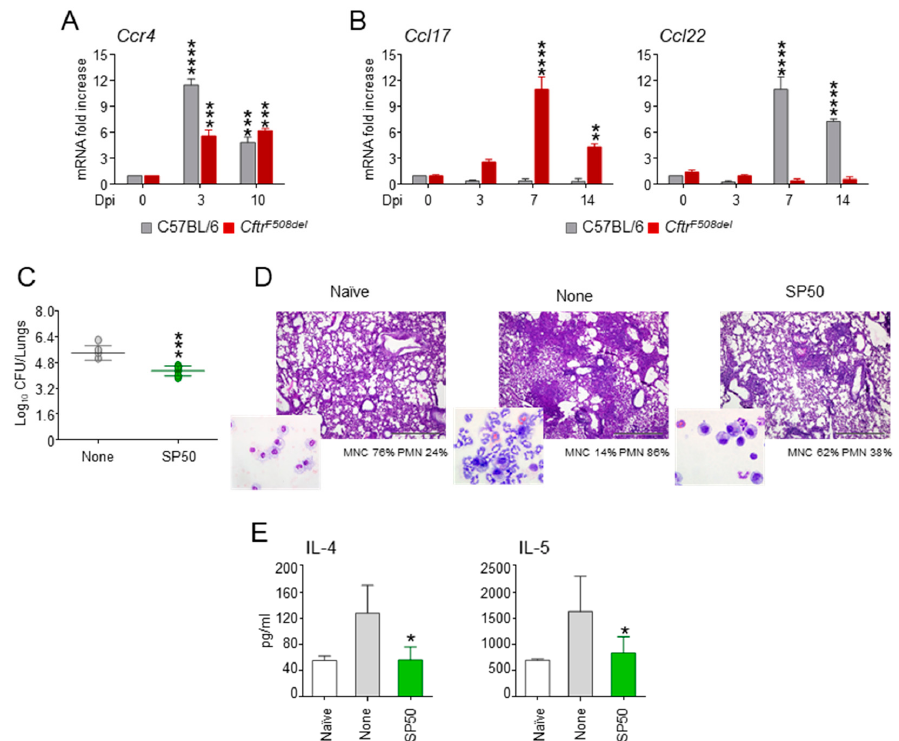
Figure 4. SP50 protects from aspergillosis in a murine model of cystic fibrosis. C57BL/6 and Cftr F508del mice were infected intranasally (in) with A. fumigatus and treated with SP50 administered (5 µ g/mouse/in) in concomitance with Aspergillus inoculation. ( A ) Expression of CCR4 and ( B ) its ligands CCL17 and CCL22 during infection. ( C ) Cftr F508de l mice were assessed for fungal growth (Log10 CFU) in the lungs at 7 days post-infection (Dpi). In ( D ) lung histology (periodic acid-Schiff staining) of A. fumigatus -infected and SP50-treated mice (% of neutrophils in the bronchoalveolar lavage are shown in the insets). ( E ) Cytokines were determined in lung homogenates 7 days after the infection by ELISA. Data are pooled from three independent experiments. Na ̈ ı ve, uninfected and untreated mice. *, p < 0.05, **, p < 0.01, ***, p < 0.001, ****, p < 0.0001, SP50 ‐ treated treated vs untreated (None) mice and Dpi 3 and 10 vs 0.